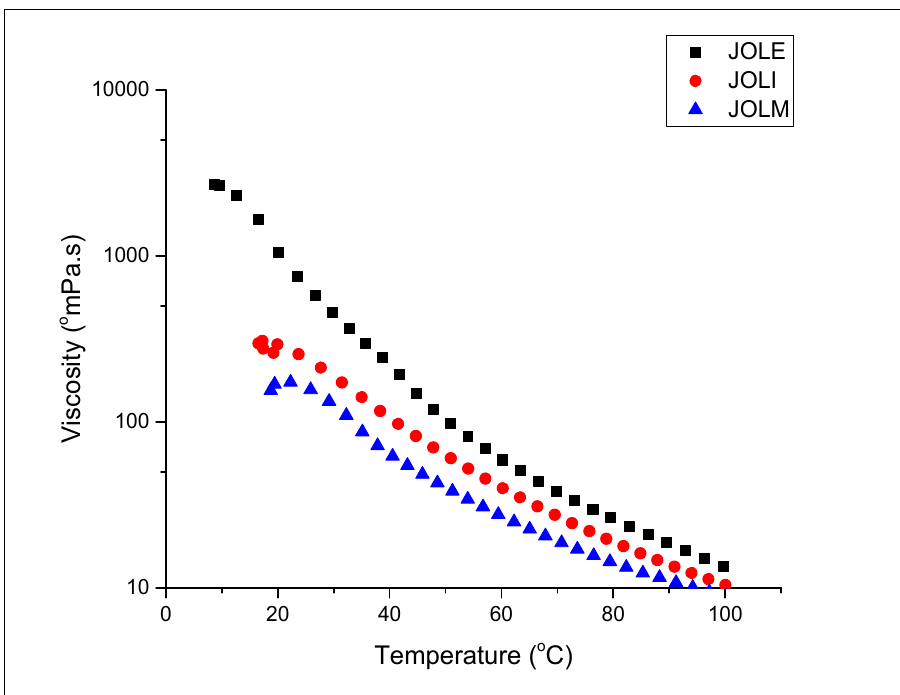
Figure 4. Viscosity of all JOLs at various temperatures.